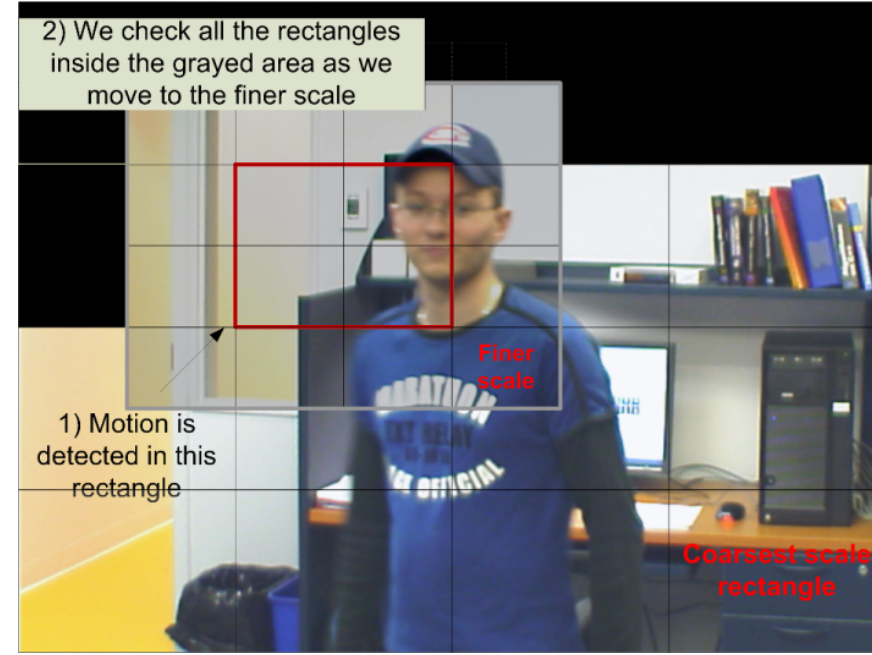
Figure 6. An example of motion detection as the algorithm progresses into scale. Black rectangles illustrate regions labeled as background. Motion is detected in the rectangle indicated. When, the algorithm moves to a finer scale, it will consider all the rectangles in the grayed